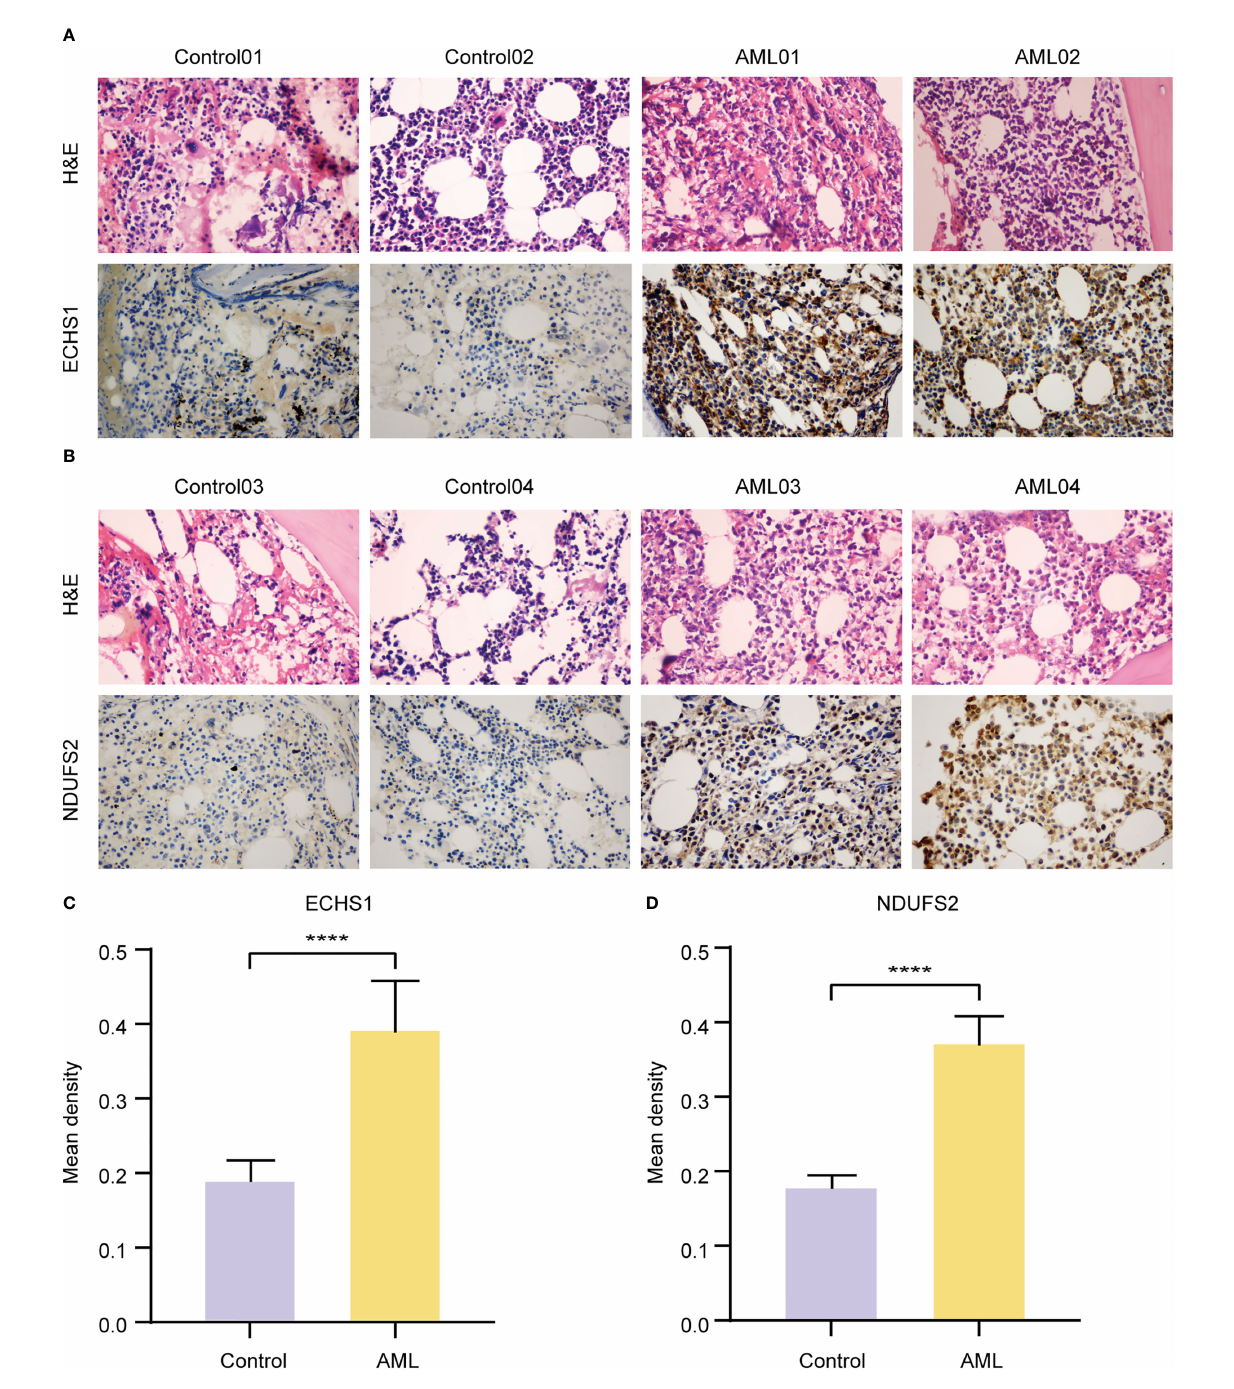
FIGURE 7 Validation of the expression levels of key MMRGs by IHC. A-B. H&E and ECHS1 (A) and NDUFS2 (B) IHC staining of BM samples from nonneoplastic patients and AML patients. Original magni fi cation, 400X. (C-D) . Statistics of ECHS1 (C) and NDUFS2 (D) mean IOD from IHC images of nonneoplastic patients (n = 10) and AML patients (n = 10).